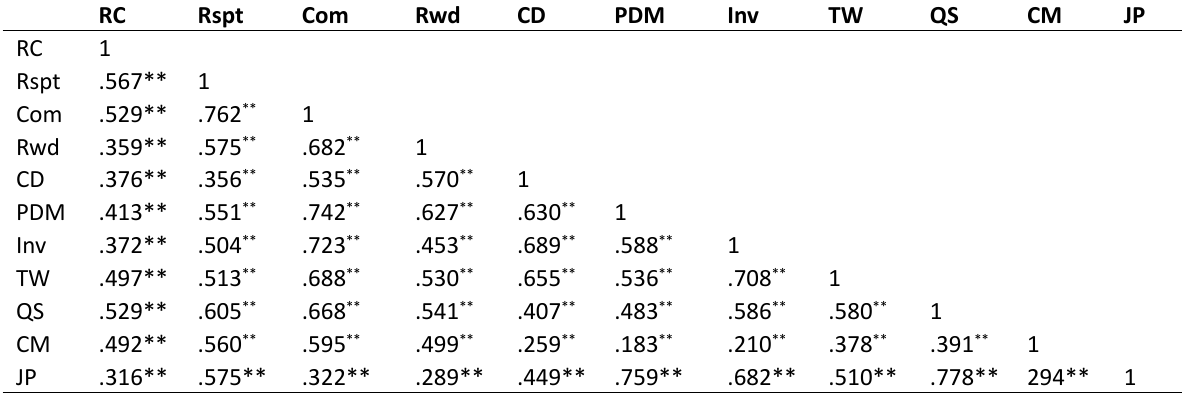
Table 2. Showing Content Validity Ratio (CVR) Table 3. Showing reliability score of the instrument Scale Table 4. Correlation Analysis Matric of Organizational Climate and Job performance